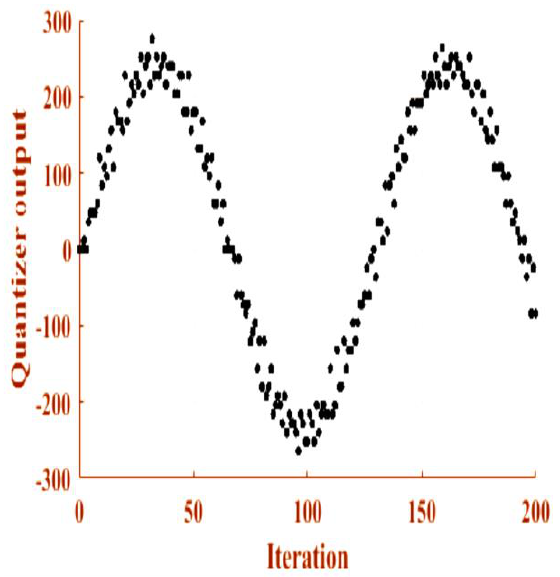
Figure 9. Quantizer output of Hybrid MASH-EFM.